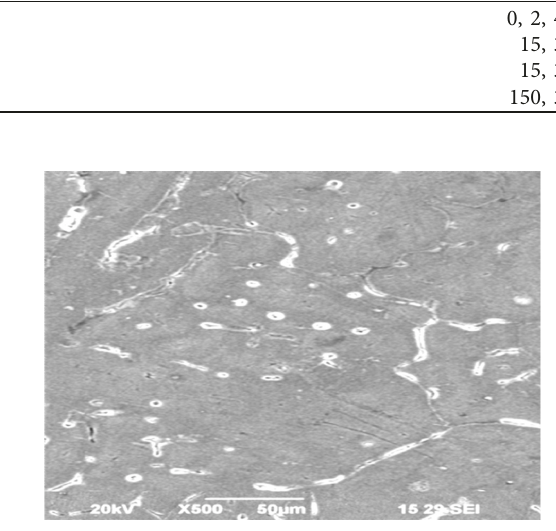
Figure 2: Microstructure of AA7050/Al2O3